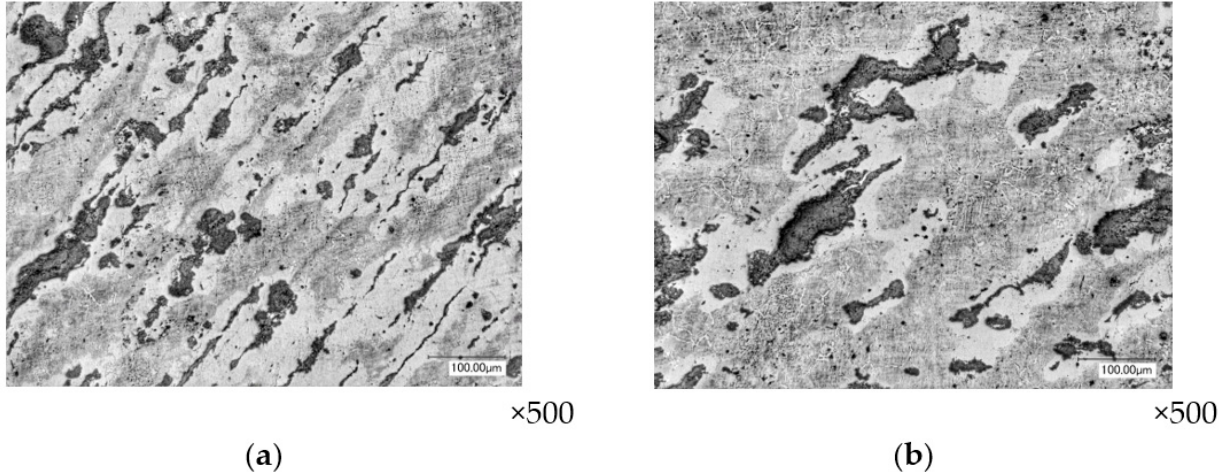
Figure 8. The shape of graphite inclusions on the radius section of the transition of the flange to the pipe part of the forging (layer № 3): layered section ( a ) and end section ( b ).